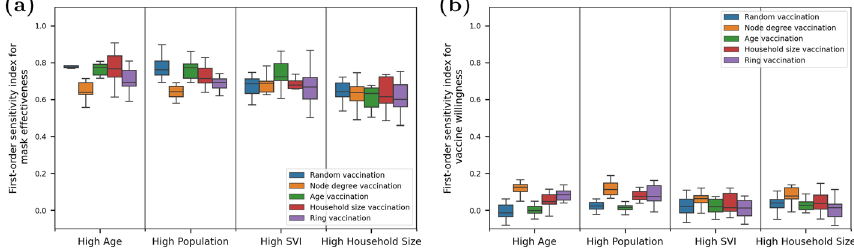
Fig. 13 Distribution of first-order sensitivity for a mass effectiveness and b vaccine willingness on peak hospitalizations. Results are grouped by community and vaccine prioritization. Each box includes the 25th, 50th and 75th percentile for the model output, with whiskers that extend to 1.5 times the interquartile range